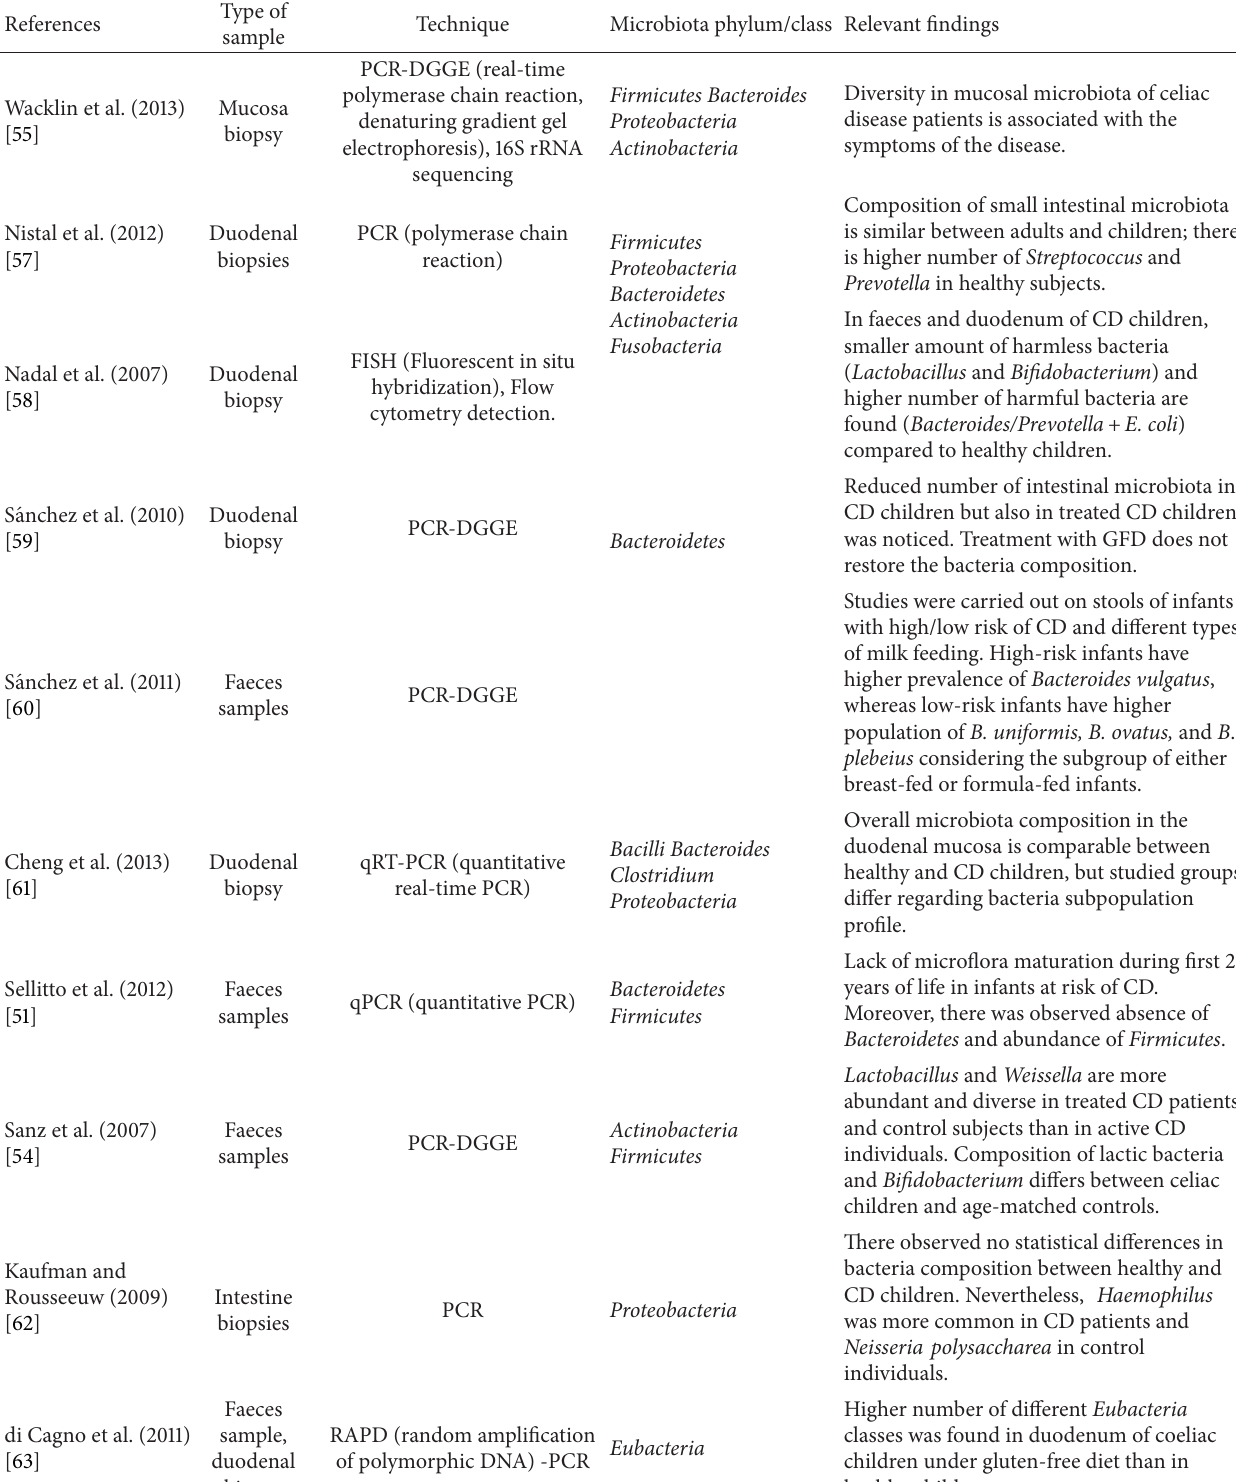
Table 1: Most relevant findings, and associated references, for studies linking gut microbiota and